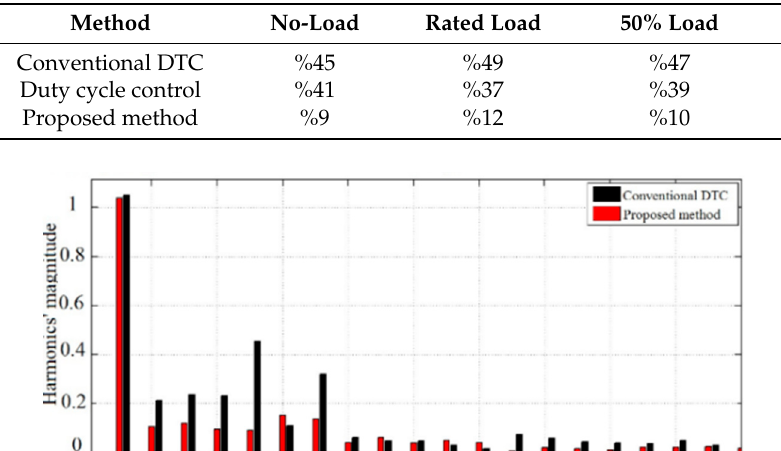
Table 5. Torque ripples in three different conditions of 6PIM driving by three different methods.